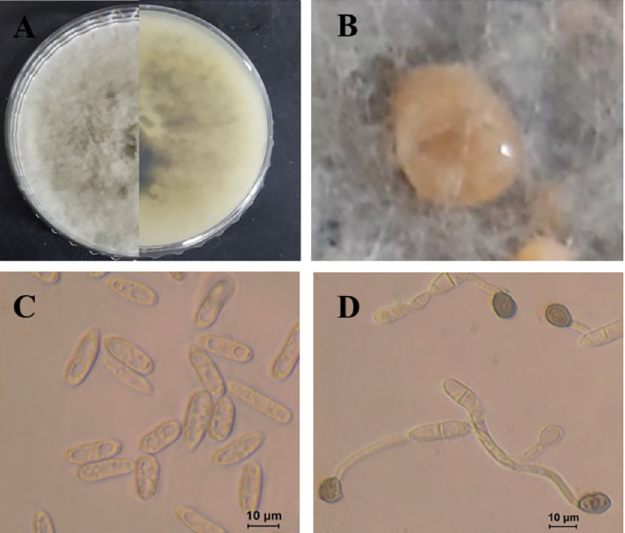
Fig 10. Morphological characteristics of C . gloeosporioides s . s . (isolate SPL912). A: Colony on PDA above and below. B: Conidioma. C: Conidia. D: Appressoria.